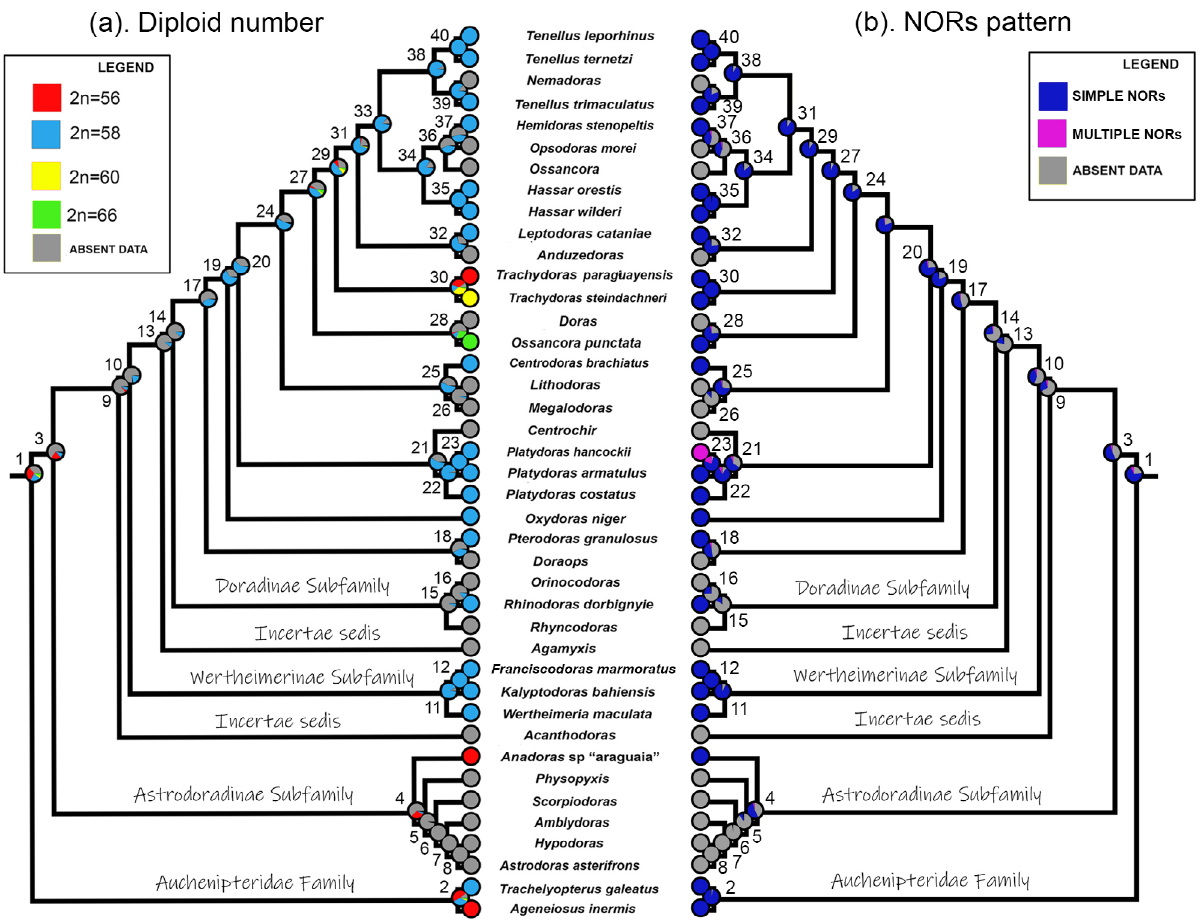
Figure 3 – Mirror trees showing maximum likelihood ancestral state reconstructions of diploid number and NORs pattern, based on Mk1 model using the Mesquite software. This evolutionary analysis integrated cytogenetic data available for Doradidae species (including the present study) and two Auchenipteridae species (sister group) with sequences of two mitochondrial DNA fragments (COI and 16S) and one nuclear DNA fragment (Rag 1) obtainad from the molecular phylogeny of Arce et al .